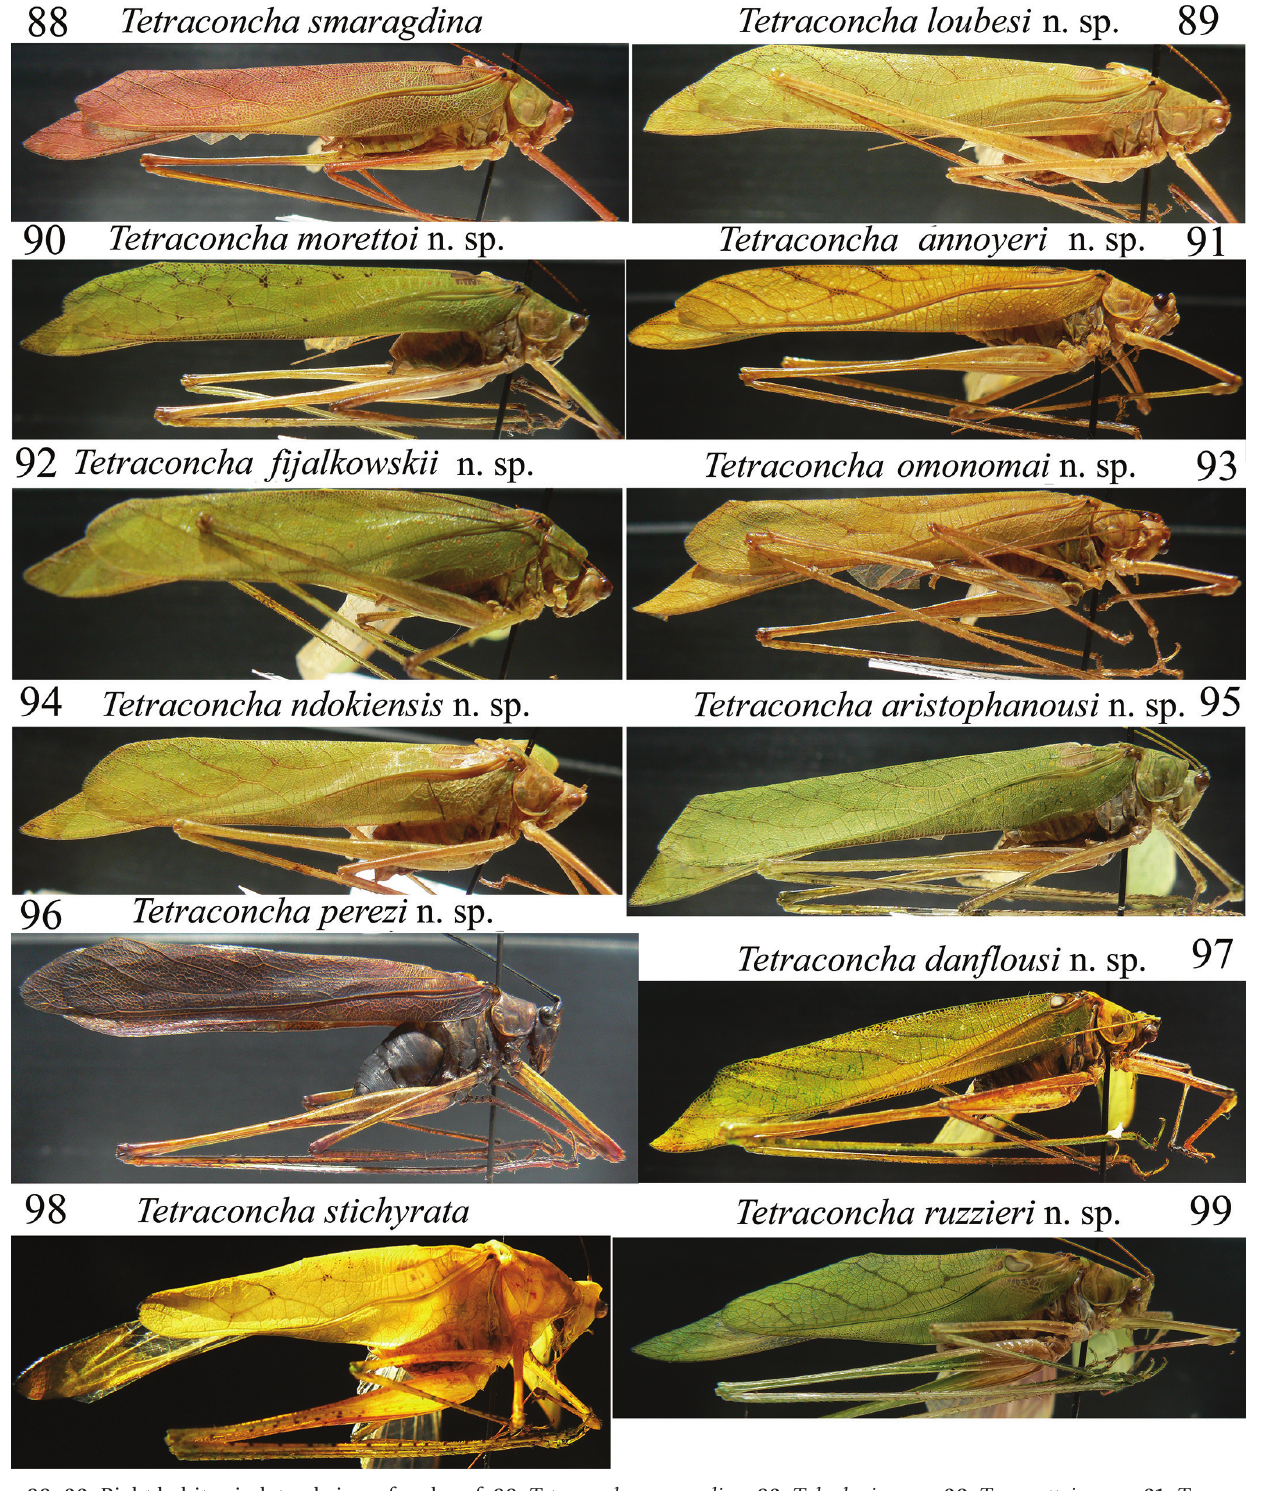
Figs 88–99. Right habitus in lateral view of males of: 88. Tetraconcha smaragdina ; 89. T. loubesi sp. n.; 90. T. morettoi sp. n.; 91. T. annoyeri sp. n.; 92. T. fijalkowskii sp. n.; 93. T. omonomai sp. n.; 94. T. ndokiensis sp. n.; 95. T. aristophanousi sp. n.; 96. T. perezi sp. n.; 97. T. danflousi sp. n.; 98. T. stichyrata ; 99. T. ruzzieri sp.